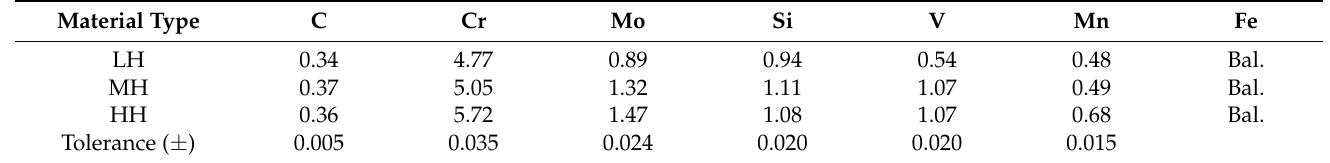
Figure 1. SEM images of the pre-alloyed powders of ( a ) LH, ( b ) MH, and ( c ) HH. Table 1. The chemical composition of the pre-alloyed powders. (wt